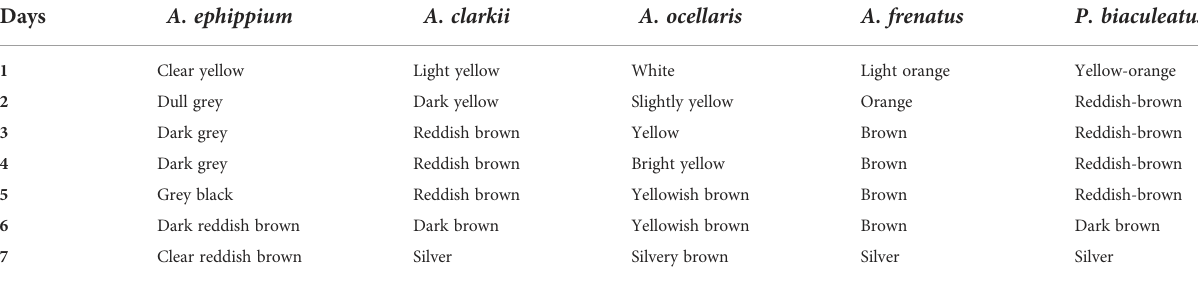
TABLE 3 Colour changes during egg development.